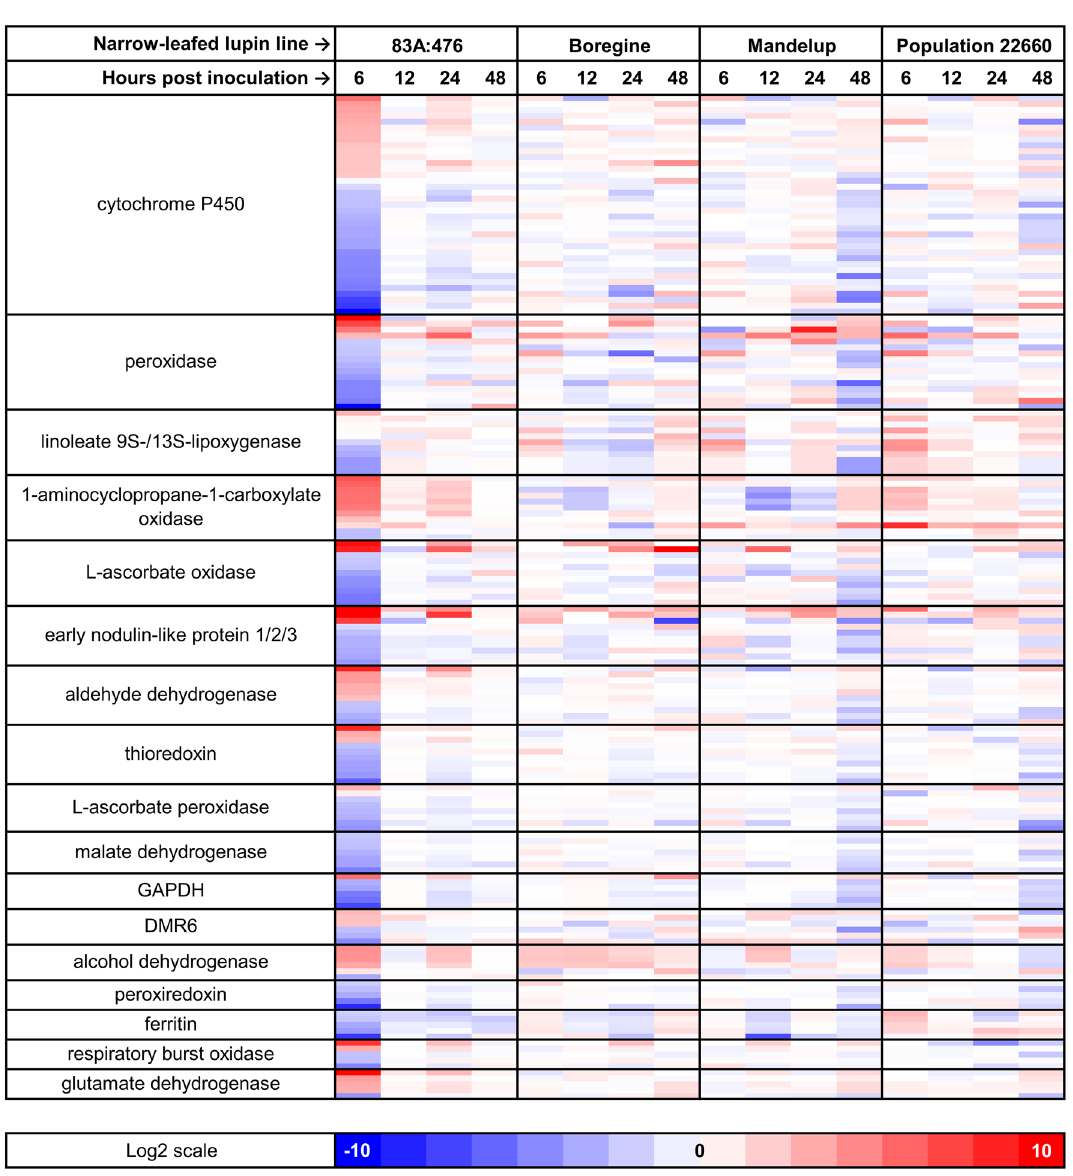
Figure 4. Expression patterns revealed for major components of biological process term “GO:0055114 oxidation–reduction process”. Log2 scale represents the log2(fold-change) values between inoculated ( Colletotrichum lupini , strain Col-08, obtained in 1999 from the lupin field in Wierzenica, Poland) and control (mock inoculation) plants at the same time point. Analyzed narrow-leafed lupin lines were as follows: 83A:476 (resistant, carrying homozygous Lanr1 allele), Boregine (resistant, unknown genetic background), Mandelup (moderately resistant, carrying homozygous AnMan allele), and Population 22660